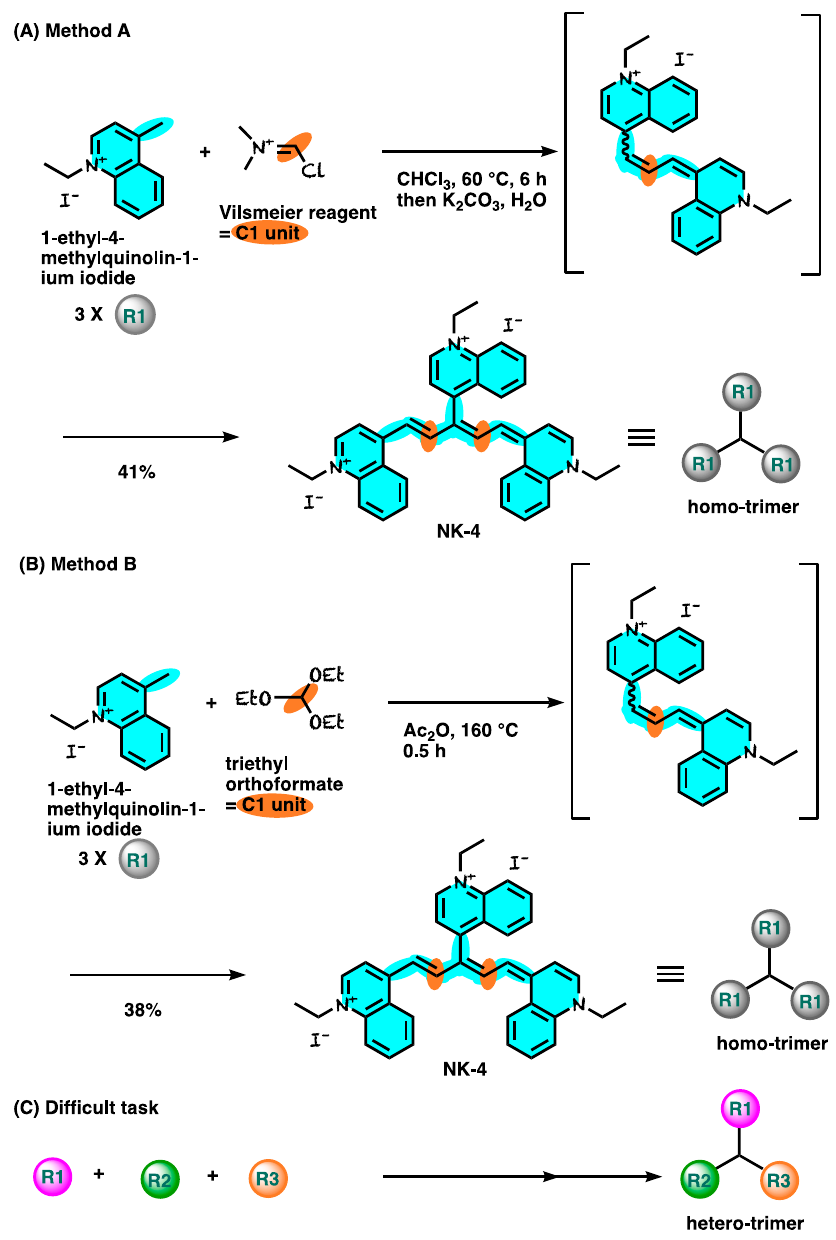
Figure 4. Synthetic route for